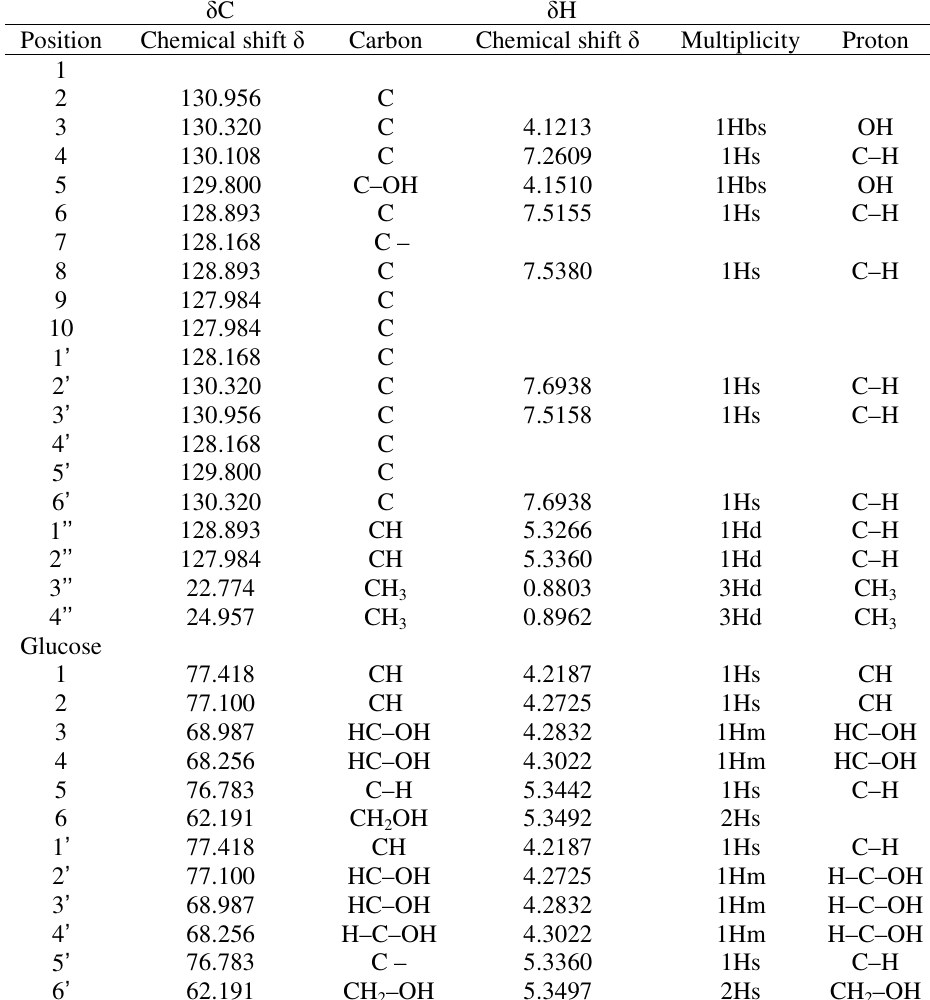
Table 1. 1 H (400 mHz) and 13 C NMR (75 mHz) of compound ( 1